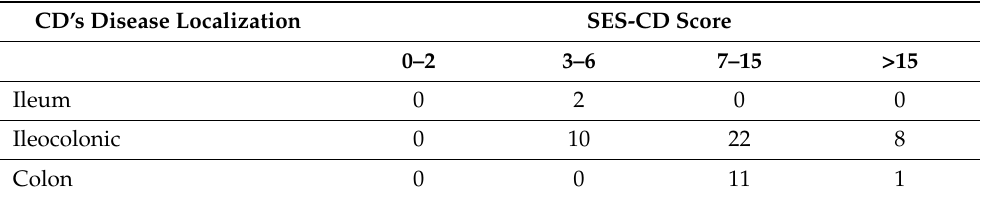
Table 5. Disease localization and disease activity evaluated by using the Endoscopic Score for Crohn’s Disease